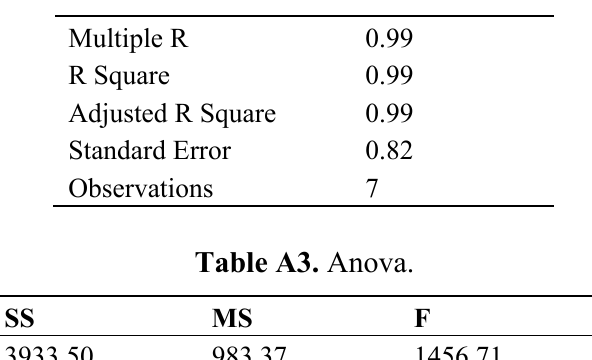
Table A2. Summary Output—Regression Statistics.